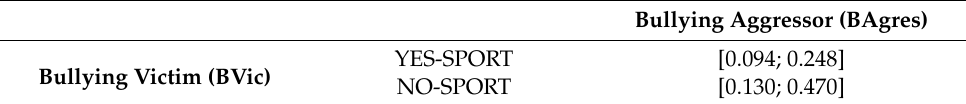
Table 6. Discriminant validity. Heterotrait-Monotrait Ratio.